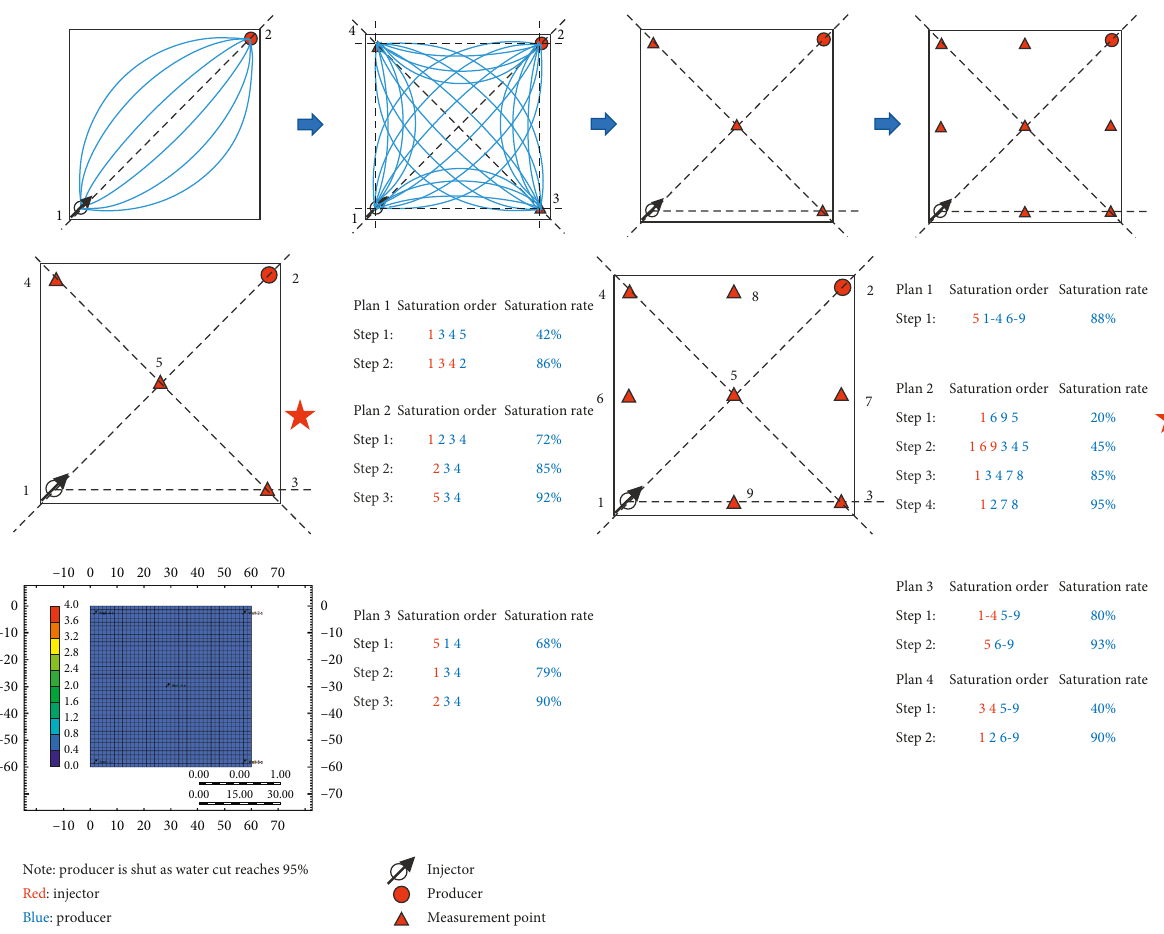
Figure 2: Optimization of saturation process.